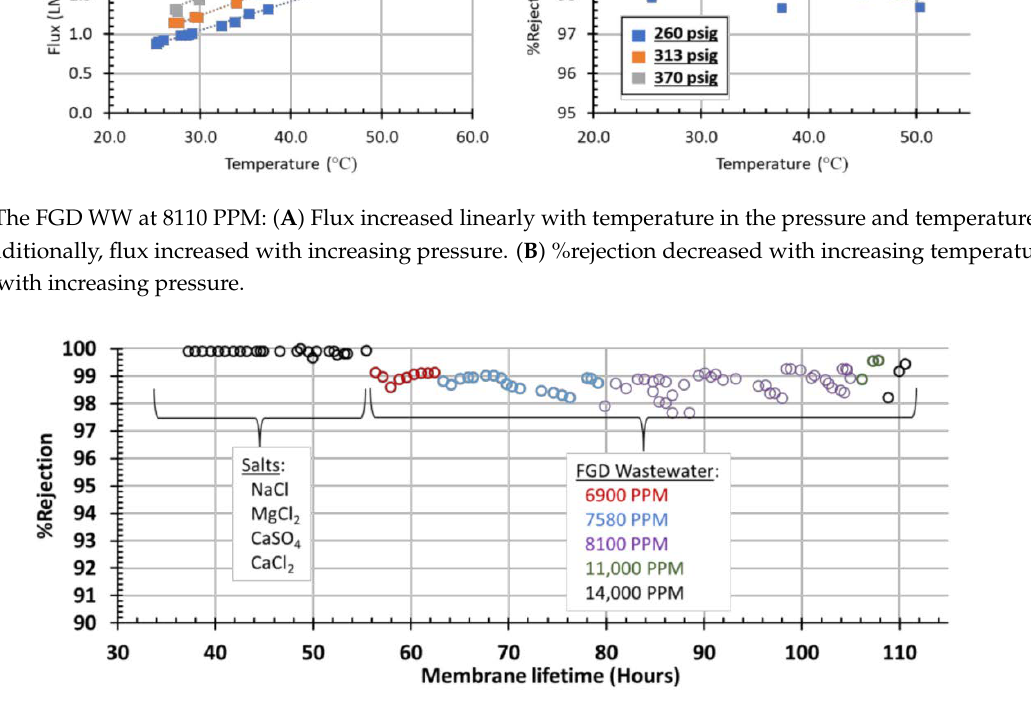
Figure 8. The image shows the %rejection for all reported runs on Module 1. The membrane showed near complete rejection for the single-component salt solutions and >97% under all operating conditions for the real FGD WW.